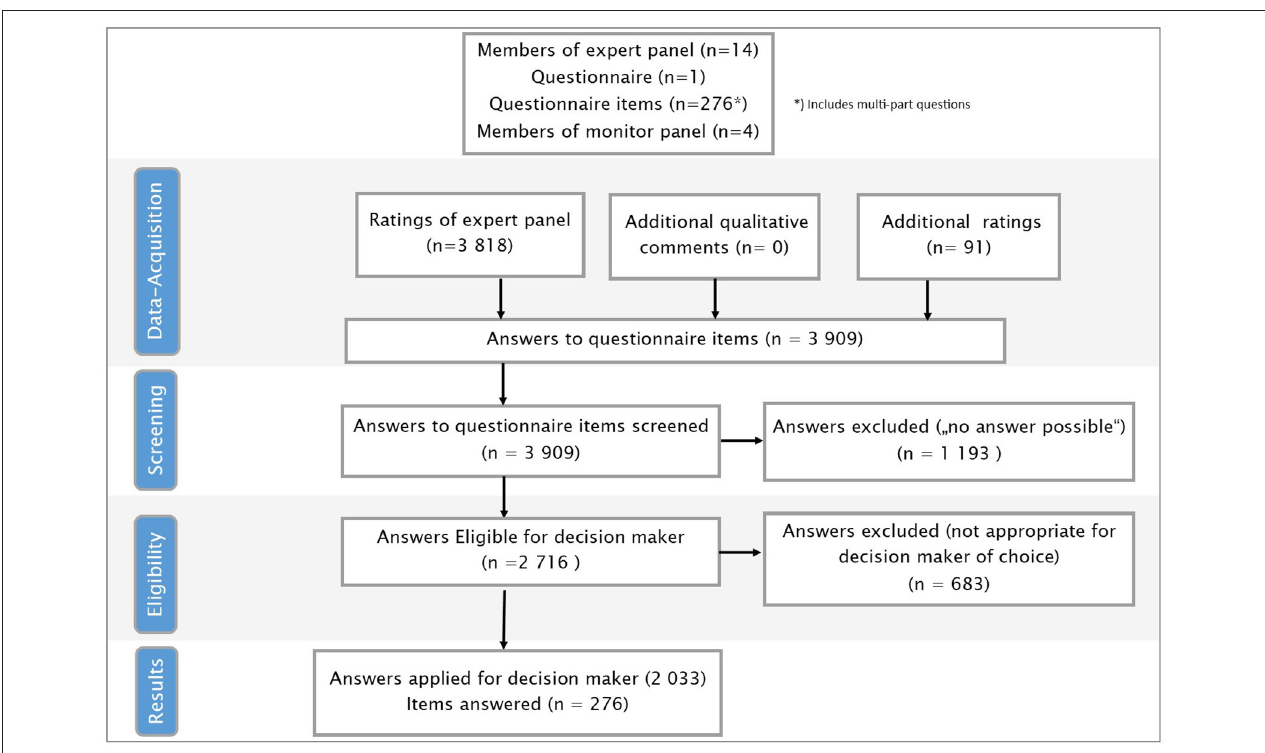
FIGURE 5 | Flowchart